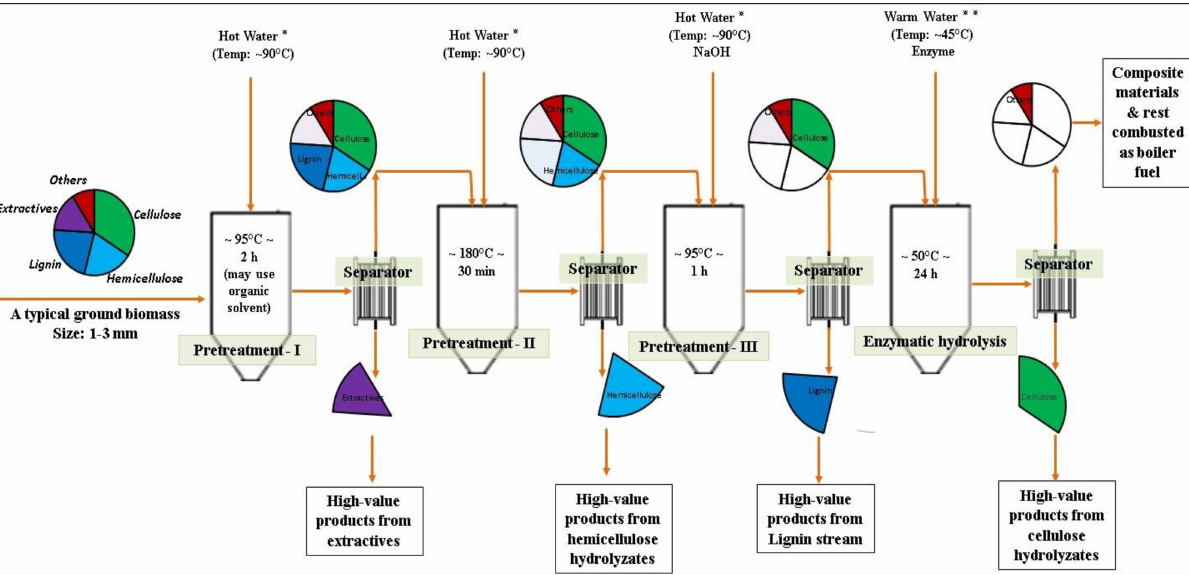
Figure 5. Schematic of an integrated biorefinery using a combination of multiple pretreatment methods followed by a secondary enzyme process to generate various streams and thereby valorize each component of lignocellulosic biomass. The processing conditions proposed in the schematic may be applicable for agriculture residues with high extractives such as bmr sorghum; however, exact conditions should be optimized for each type of biomass feedstocks [25,85]. * Hot water around 90 ◦ C is obtained from heat-exchanging with the biomass slurry after liquid-hot-water pretreatment at around 180 ◦ C. ** Warm water around 45 ◦ C is obtained from heat-exchanging with the biomass slurry after alkali pretreatment at 95 ◦